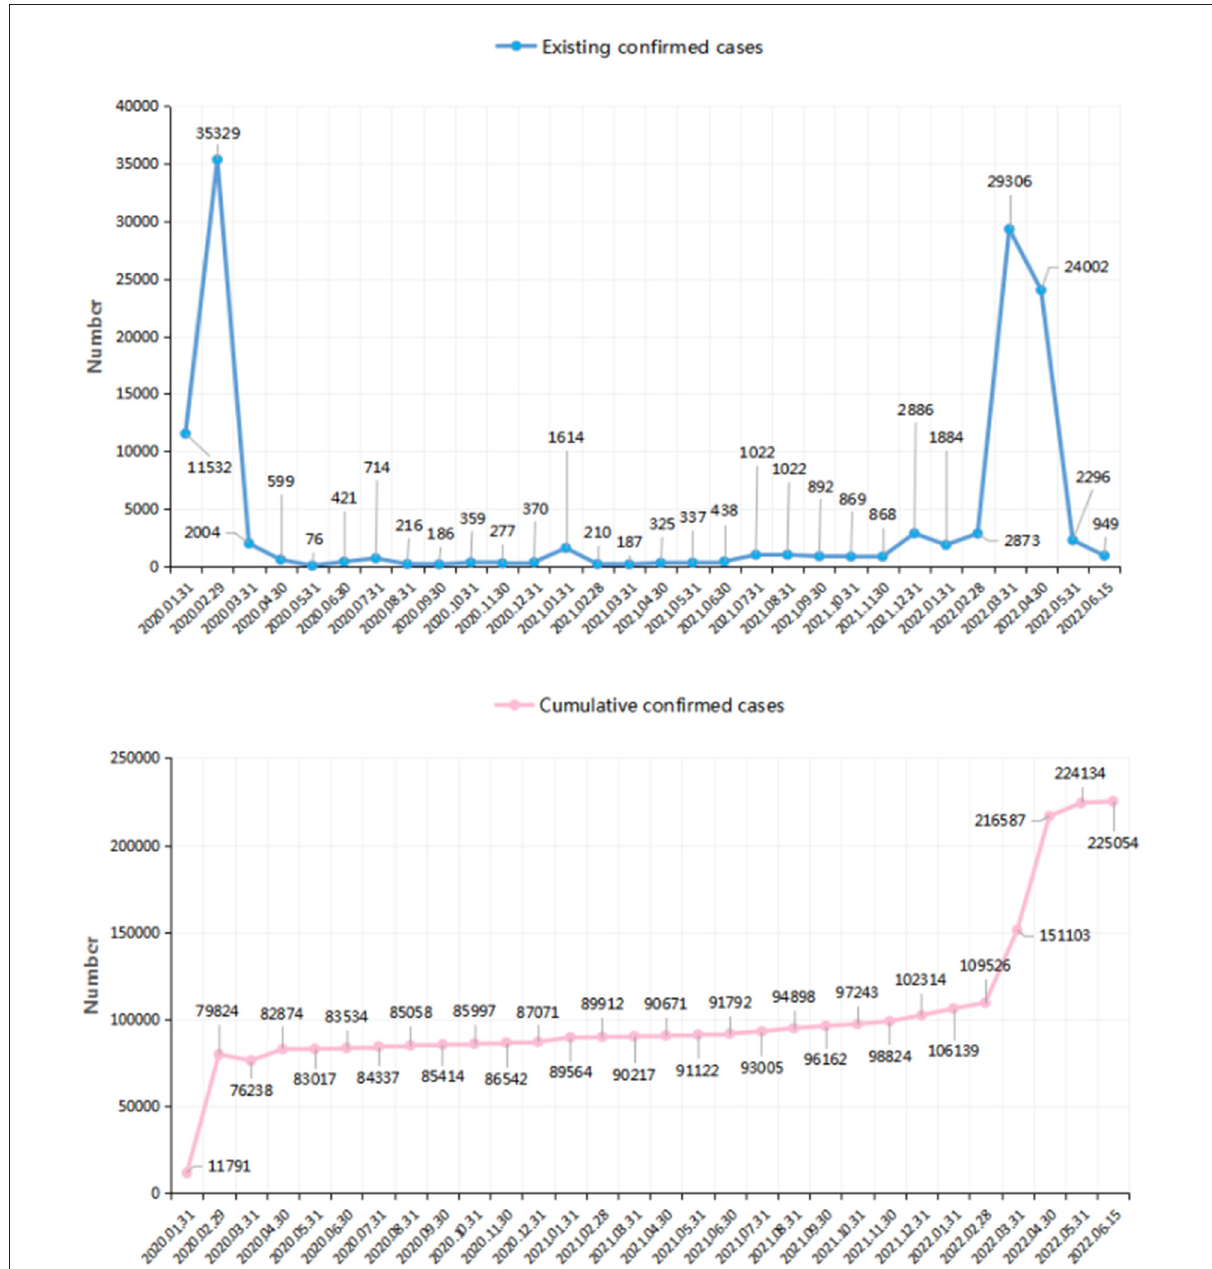
FIGURE1 The confirmed cases of patients infected of COVID-19 in China over time (the number came from the data released by the National Health Commission of the People’s Republic of China.